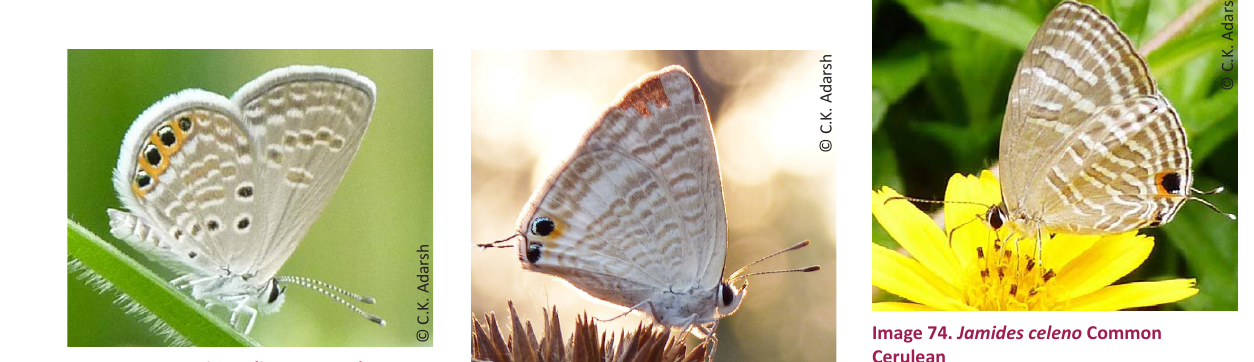
Image 72. Freyeria putli Grass Jewel